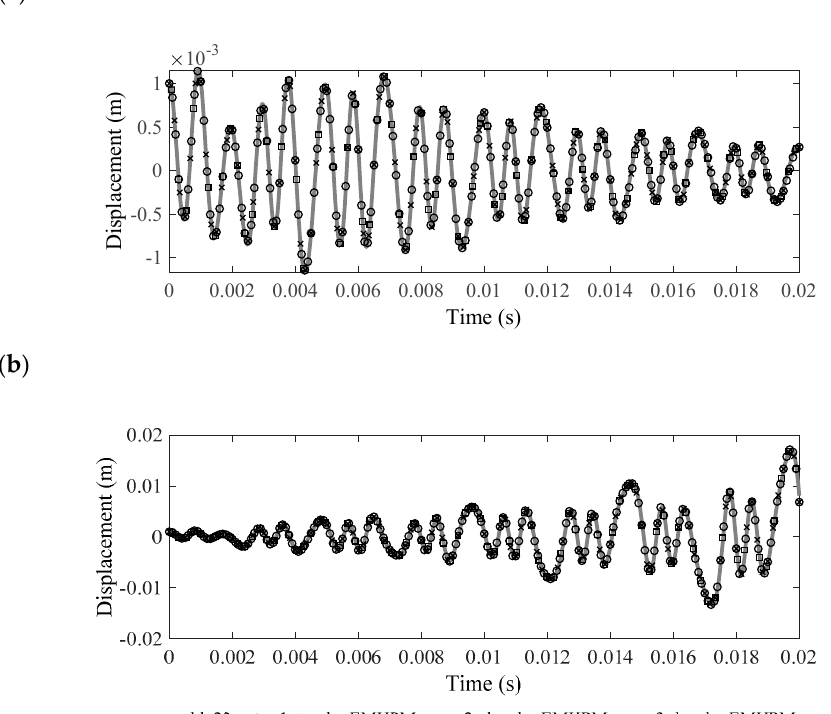
Figure 2. Numerical comparison of the enhanced homotopy perturbation method (EMHPM) solutions of the milling equation, Equation (23), with the dde23 MATLAB routine. ( a ) Stable milling operation with a p = 1.5 mm, a d = 1 and n = 12000 rpm and ( b ) unstable milling operation with a p = 3 mm, a d = 1 and n = 12000 rpm.